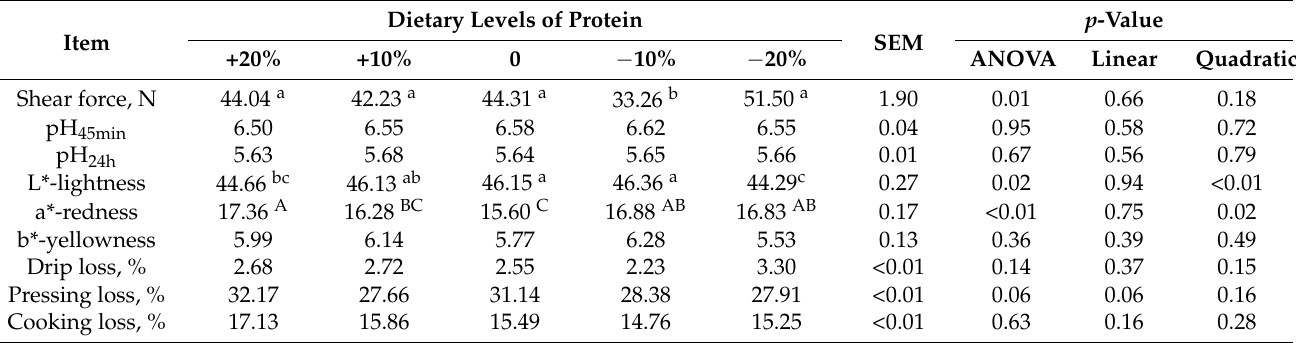
Table 5. Effects of long-term protein restriction on meat quality traits in longissimus thoracis muscle of Shaziling